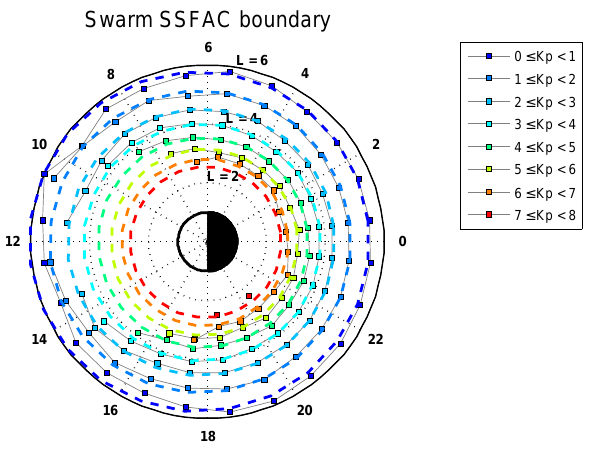
Figure 9. Empirical model of the inner SSFAC boundary.